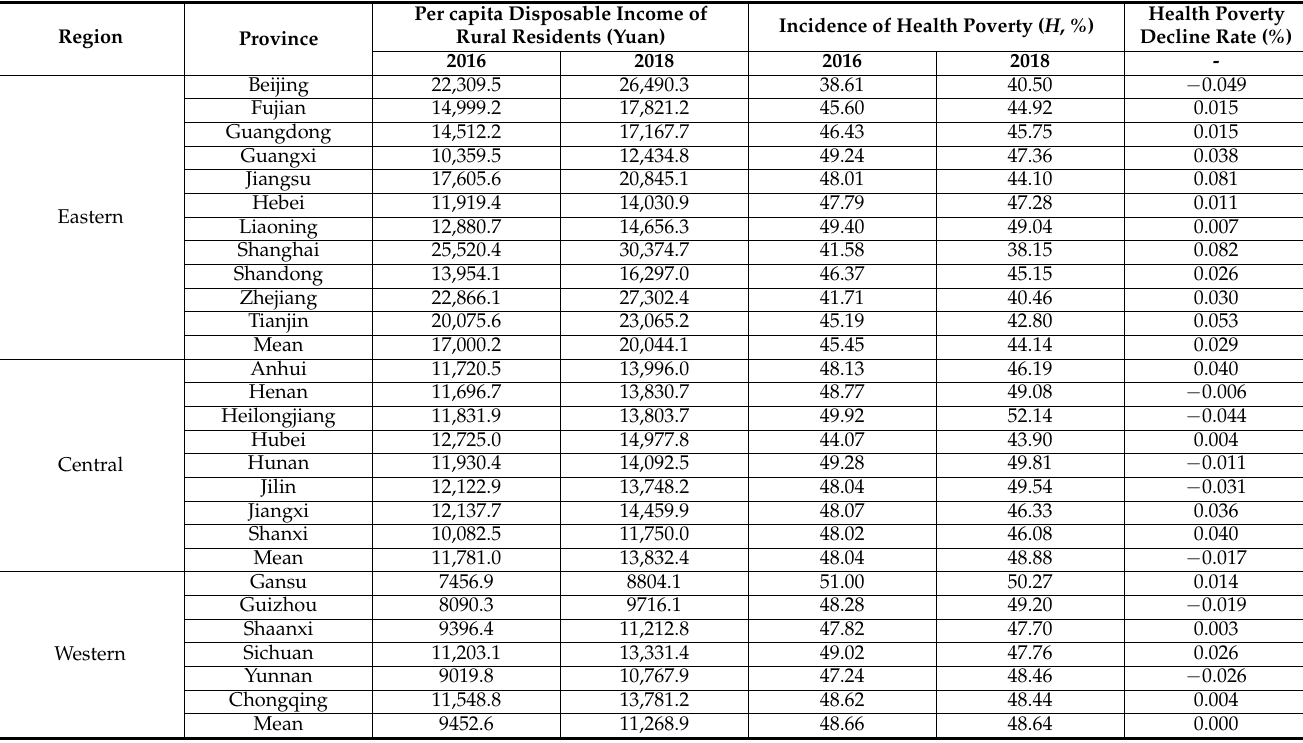
Table 6. Regional decomposition of the incidence of health poverty.